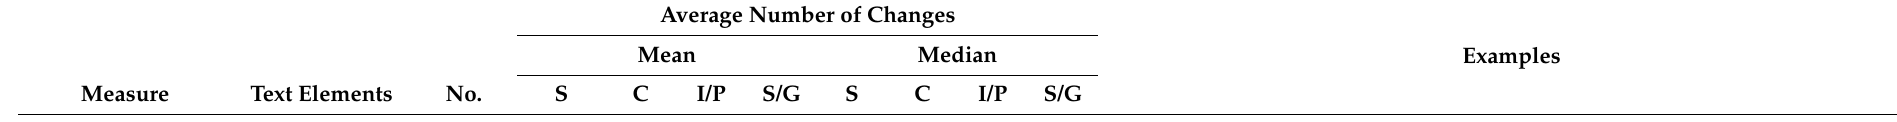
Table 8. Average (mean and median) number of differences between the first harmonized and the final internationally harmonized